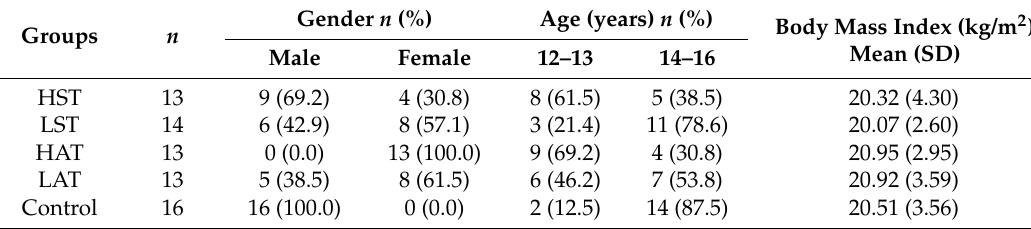
Table 1. Participants’